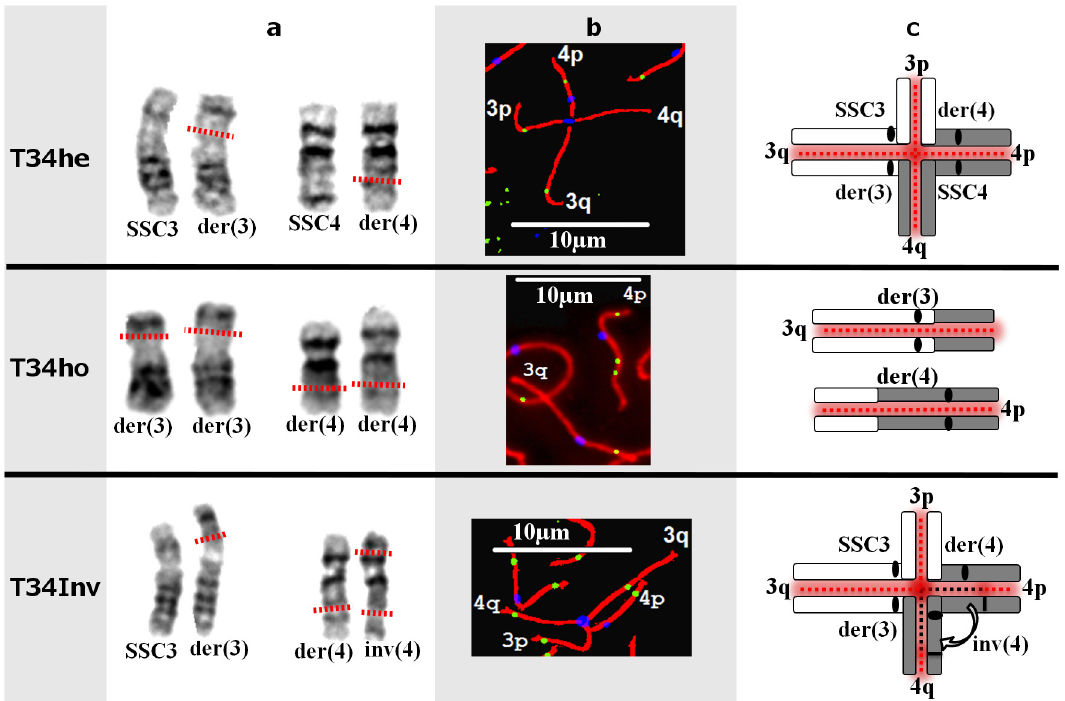
Fig 1. GTG banding and synapsis at meiosis-I for each chromosomal rearrangement. (a) GTG banding of the chromosomes involved in the rearrangements. The dotted lines in red represent the breakpoints locations. (b) Identification of chromosome arms on spermatocytes after FISH of BAC clones (more details in S1 Fig) and immunolocalization of SCP1-SCP3 (red), MLH1 (green) and kinetochores (blue). (c) Schematic representation of the synapsis between chromosomes. The dotted lines in red represent the normal synapsis, the dotted line in black the heterosynapsis, the white rectangles represent the SSC3 chromatin and the grey rectangles the SSC4 chromatin, the black ovals represent the centromeres and the black lines on the T34Inv represent the